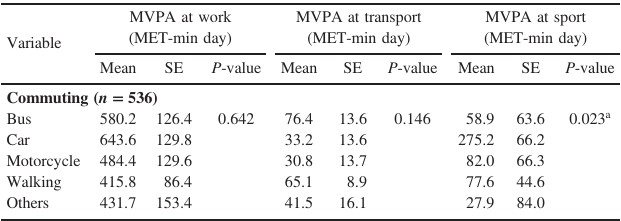
Table 4. Adjusted HRQOL measures in respondents among physical activity groups